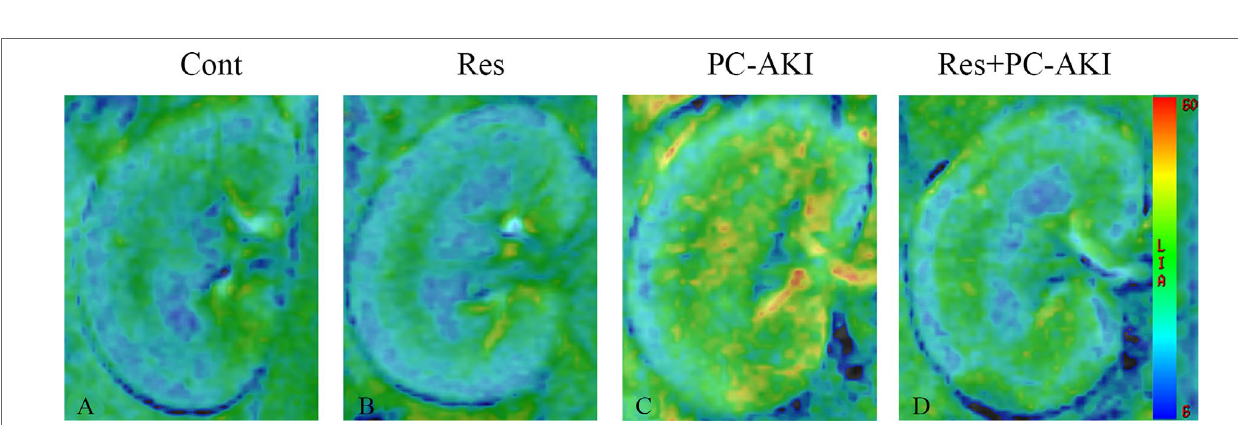
FIGURE 2 | Parametric images obtained from the intravoxel incoherent motion (IVIM) model for rabbit with different treatments. Representative IVIM images of D (A) , D * (B) , and f (C) maps. The maximum D, D * and f signal changes were observed in the PC–AKI group. The D, D * and f values increased after the application of resveratrol. Cont, control; Res, resveratrol; PC–AKI, post-contrast acute kidney injury; IVIM, intravoxel incoherent motion.